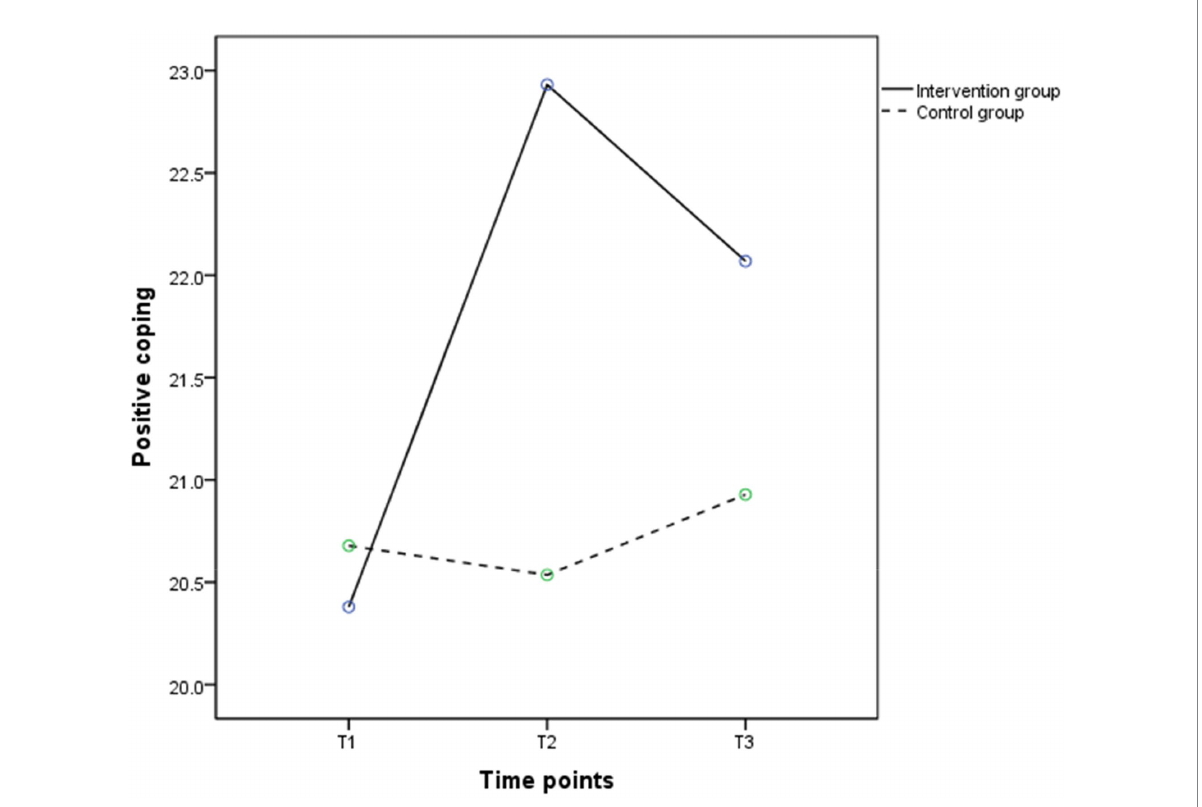
FIGURE 4 The trends in mean scores of positive coping in the intervention (solid line) and control groups (dashed line) between baseline and 3 months post intervention.